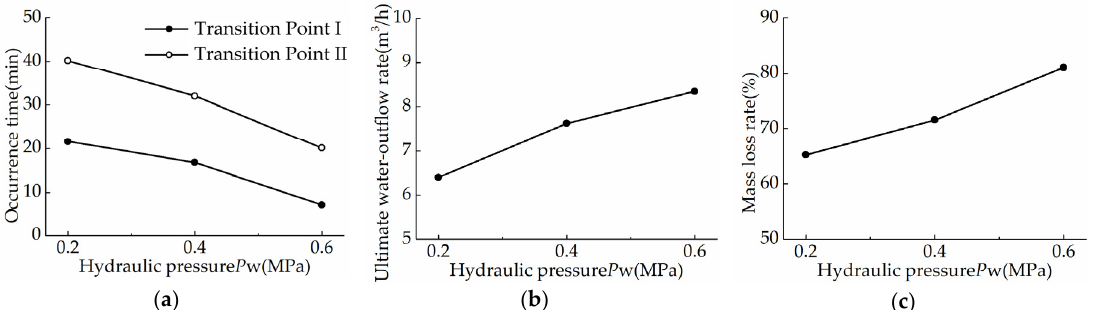
Figure 12. Variation tendency of monitoring objects’ characteristic value with hydraulic pressure ( P w ). ( a ) Occurrence time of Transition Point I, II along with hydraulic pressure; ( b ) Ultimate water-outflow